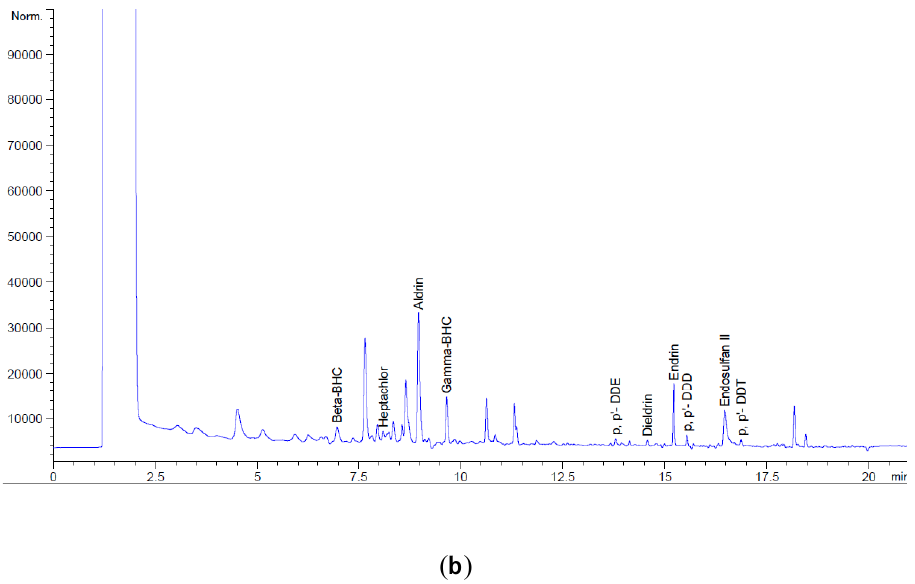
Figure 1. ( a ) Chromatogram of the OCPs mix standard; ( b ) Representative chromatogram of the samples analyzed in this study. Table 2. Retention Time, LOD, LOQ and % Recovery for OCPs.